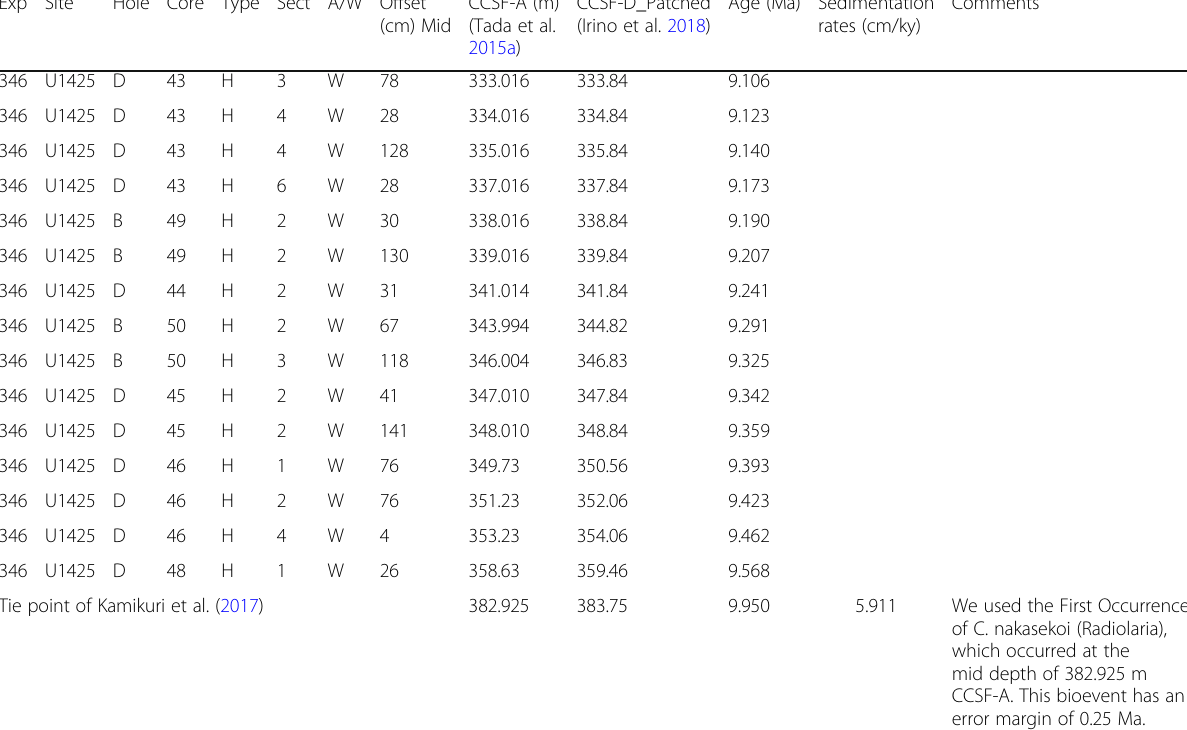
Table 1 Samples used, biostratigraphic tie points, and related sedimentation rates at IODP Site U1425 (cm/ky) (Continued) Exp